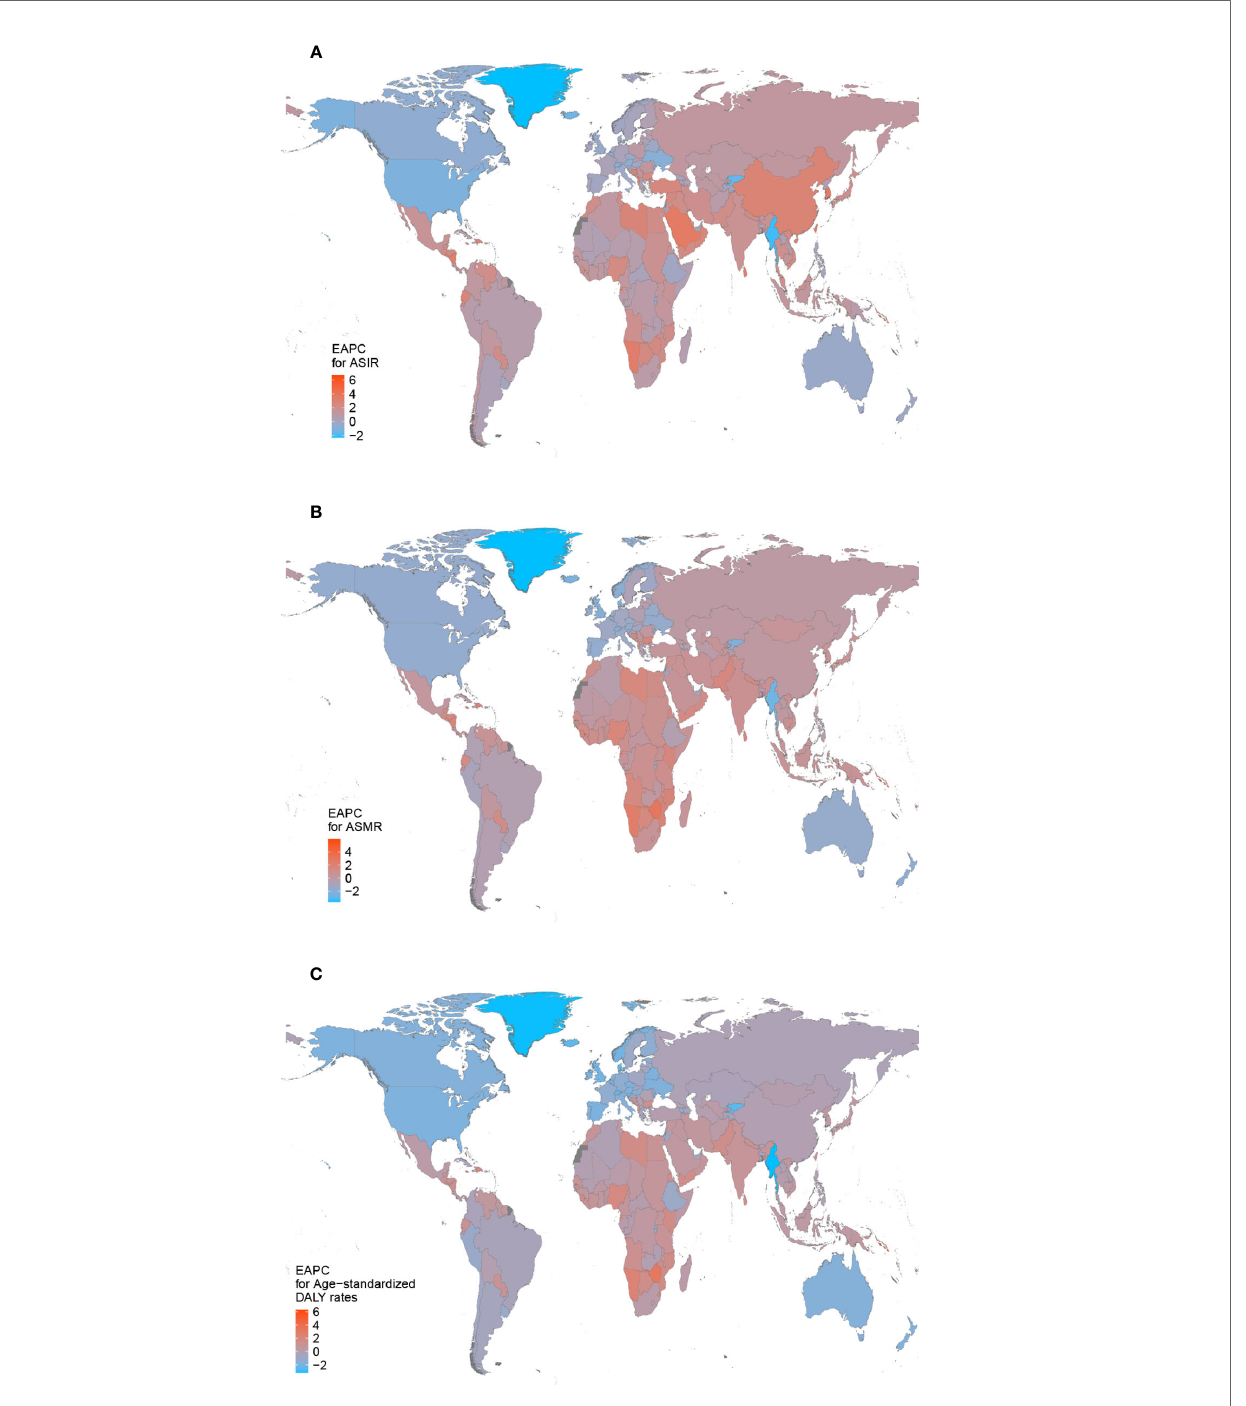
FIGURE 1 | The estimated annual percentage changes (EAPCs) of breast cancer in 204 countries and territories between 1990 and 2019. (A) The EAPC of age- standardized incidence rates (ASIR). (B) The EAPC of age-standardized mortality rates (ASMR). (C) The EAPC of age-standardized disability-adjusted life-year (DALY)